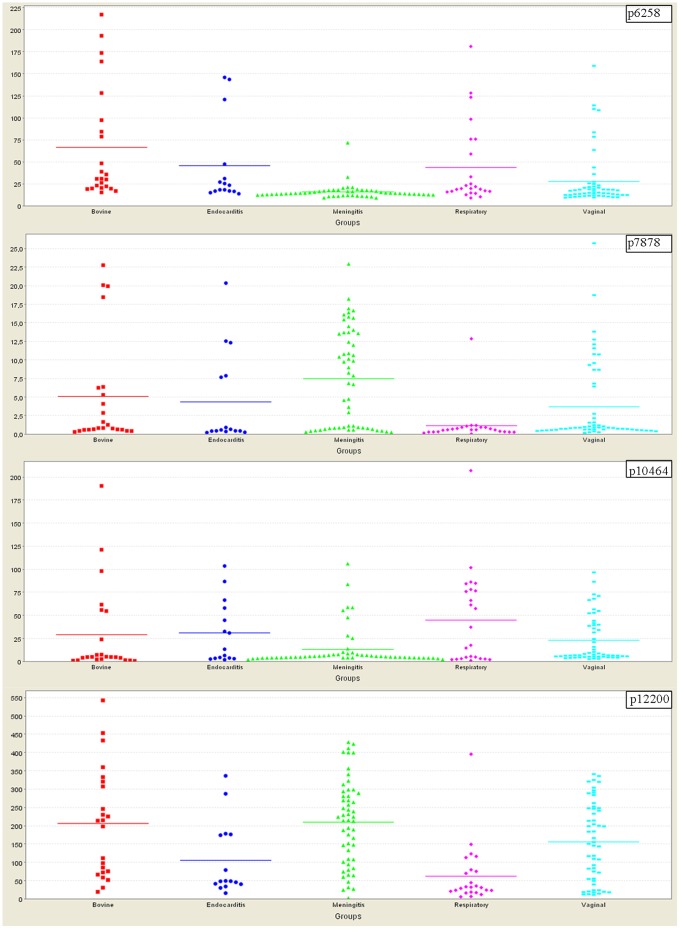
Expression levels of four biomarker proteins produced by S. agalactiae isolates clustered into five groups according to origin/clinical outcome.X - axis: bovine mastitis (red), endocarditis (blue), meningitis (green), respiratory infections (magenta), vaginal carriage (cyan). Y- axis: protein abundance expressed as absolute intensity (µA/laser pulse). Each point represents the mean intensity of one sample tested in duplicate. P-values obtained with the Kruskal-Wallis H test: p6258 -<1.10−6; p7878 - 0.000059; p10464 - 0.09447; p12200 - 0.000004.